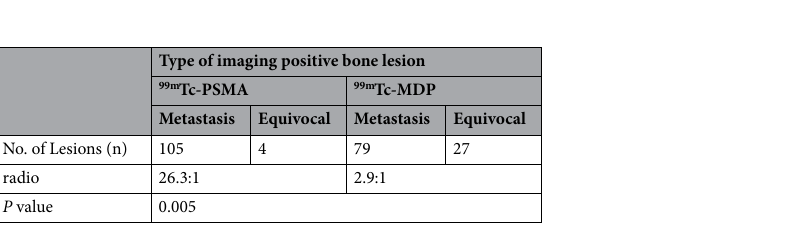
Table 3. Ratio of equivocal or metastatic lesions.